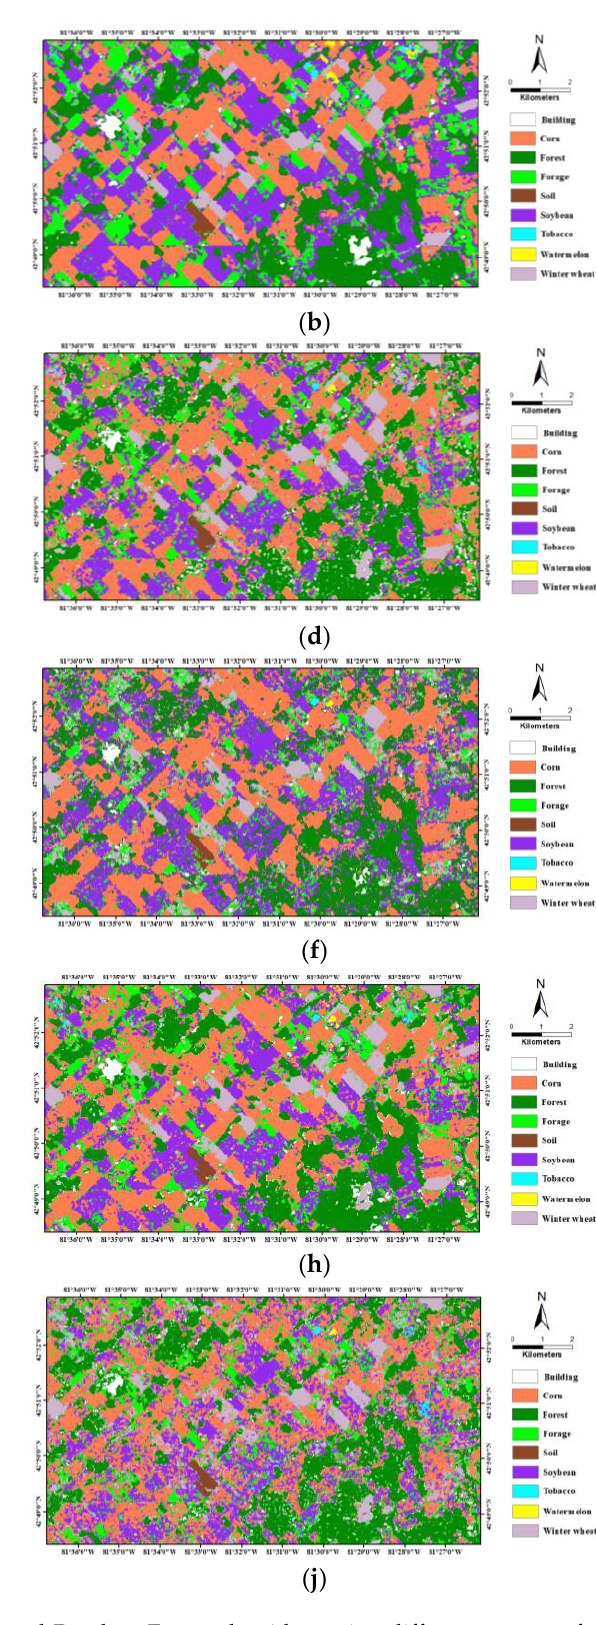
Figure 9. Classification maps with all RADARSAT-2 images and Random Forest algorithm using different groups of polarimetric observables. ( a ) LP; ( b ) Pauli; ( c ) Span; ( d ) Ra; ( e ) Ro; ( f ) Pha; ( g ) FD; ( h ) CP; ( i ) ND; ( j ) RVI.